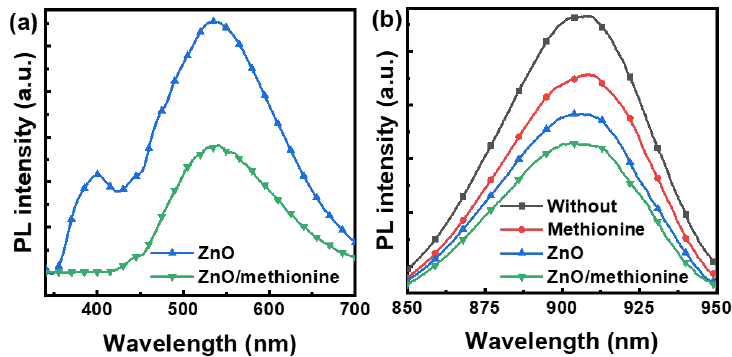
Figure 5. PL spectra of different ( a ) ETL films and ( b ) ITO/ETL/active layer films. In order to more deeply understand the influence of different ETLs on charge transport, the charge mobility was fitted by the space charge limited current (SCLC) model. Under dark state conditions, the typical log ( J ) and log ( V ) curves were obtained for the pure hole device (ITO/PEDOT:PSS/PM6:BTP-ec9/MoO 3 /Ag) and pure electron devices (ITO/ETLs/PM6: BTP- ec9/PDIN/Al), as shown in Figure S5. The slopes of the log ( J ) and log ( V ) curves of these devices are close to 1 at low applied voltage, which signifies that the interface contact in the device can be viewed as an ohmic contact. At higher applied voltages, the slope of the log ( J ) and log ( V ) curves is about 2, which indicates that the injection rate of the carriers exceeds the recombination rate, thus forming SCLC flow [55,56]. The corresponding curves of ln( Jd 3 / V 2 )-( V / d ) 0.5 for the pure hole device and pure electronic devices with different ETLs are shown in Figure S6. The calculated hole mobility ( µ h ) is 1.02 × 10 − 3 cm 2 V − 1 s − 1 . The calculated electron mobility ( µ e ) and µ h / µ e ratio of the active layer are listed in Table S3. The µ e of the active layer for the device without ETL is 4.69 × 10 − 4 cm 2 V − 1 s − 1 . The µ e of the active layer for the device with methionine or ZnO as ETL is increased to 5.72 × 10 − 4 cm 2 V − 1 s − 1 and 6.33 × 10 − 4 cm 2 V − 1 s − 1 . The µ e of the active layer for the device with ZnO/methionine as ETLs is further increased to 1.27 × 10 − 3 cm 2 V − 1 s − 1 . These data mean that the modification of methionine on the surface of ITO or ITO/ZnO is conducive to promoting electron transport. The µ h / µ e ratio of the active layer for the device without ETL is 2.18. The µ h / µ e ratios of the active layers of devices with methionine, ZnO, or ZnO/methionine as ETLs are 1.79, 1.62, and 0.80, respectively. These data show that the modification of methionine as ETL on the surface of ITO or ITO/ZnO can promote the transport balance of electrons and holes in the OSCs. To achieve effective electron extraction in OSCs, the match between the WF of ETL and the lowest unoccupied molecular orbital (LUMO) of the acceptor is a prerequisite. The CPDs of ITO/ETLs were measured by the KPFM method in order to explore the degree of the energy level matching between ETL and the active layer. The obtained CPD data and image are shown in Figure S1. The WFs are calculated by the particular WF of the ITO (4.70 eV). The WFs and CPDs are shown in Table S2 and Figure 6a for ITO/different ETLs films. Compared with ITO, the WF of ITO/methionine, ITO/ZnO, and ITO/methionine/ZnO are lowered to 4.44 eV, 4.33 eV, and 4.23 eV, respectively. The schematic diagram of the energy levels is shown in Figure 6b. The ITO modified with ZnO/methionine has the lowest WF value, which better matches the energy level of the LUMO level of the acceptor. Meanwhile, the decreased WFs of ITO/ETLs can lead to enhanced built-in potential and increased V OC . Appropriate energy level matching